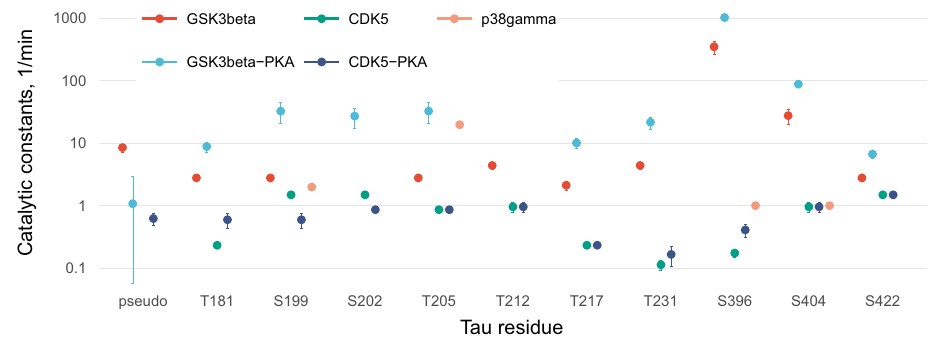
Fig 7. Values of catalytic constants on a logarithmic scale with 95% confidence